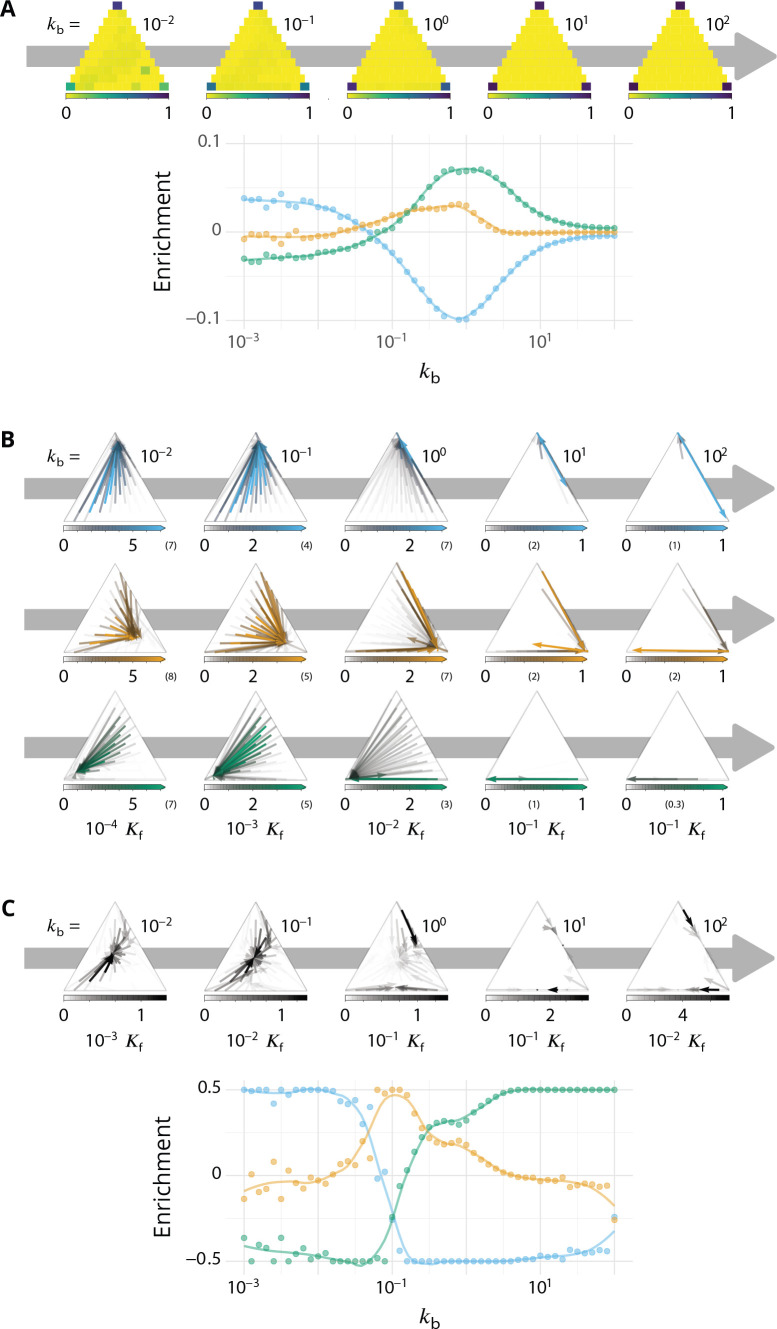
Detailed characterizations of the vesicular transport.Related to Figures 3–4 - main text. α=km=1 for all panels. (A) Characterization of vesicle back-fusion (fusion of vesicles with the same compartment or with a compartment of comparable composition). Top panel: fraction of vesicular flux undergoing back-fusion, as a function of the composition of the budding compartments, for different values of the budding rate kb. Bottom panel: non-normalized enrichment in cis (blue), medial (orange) and trans-species (green) seen by a passive cargo, between a budding and the next fusion event, as a function of kb. (B) Vesicular fluxes of cis (blue), medial (orange) and trans (green) vesicles for different values of the budding rate kb. The base of each arrow gives the composition of the donor compartment and the tip gives the average composition of receiving compartments - ignoring back-fusion - as in Figure 4, main text. The opacity of the arrows represents the normalized number of cargo (divided by the total number of cargo in the system) transported per unit time (normalized by the fusion rate). (C) Net vesicular flux, excluding vesicle biochemical conversion, for different values of the budding rate kb. Top panel: vesicular flux is represented as a vector field as in Figure 4, main text. Bottom panel: vesicular flux is represented as the enrichment between the donor and the acceptor compartment, excluding back-fusion, as in Figure 3, main text.